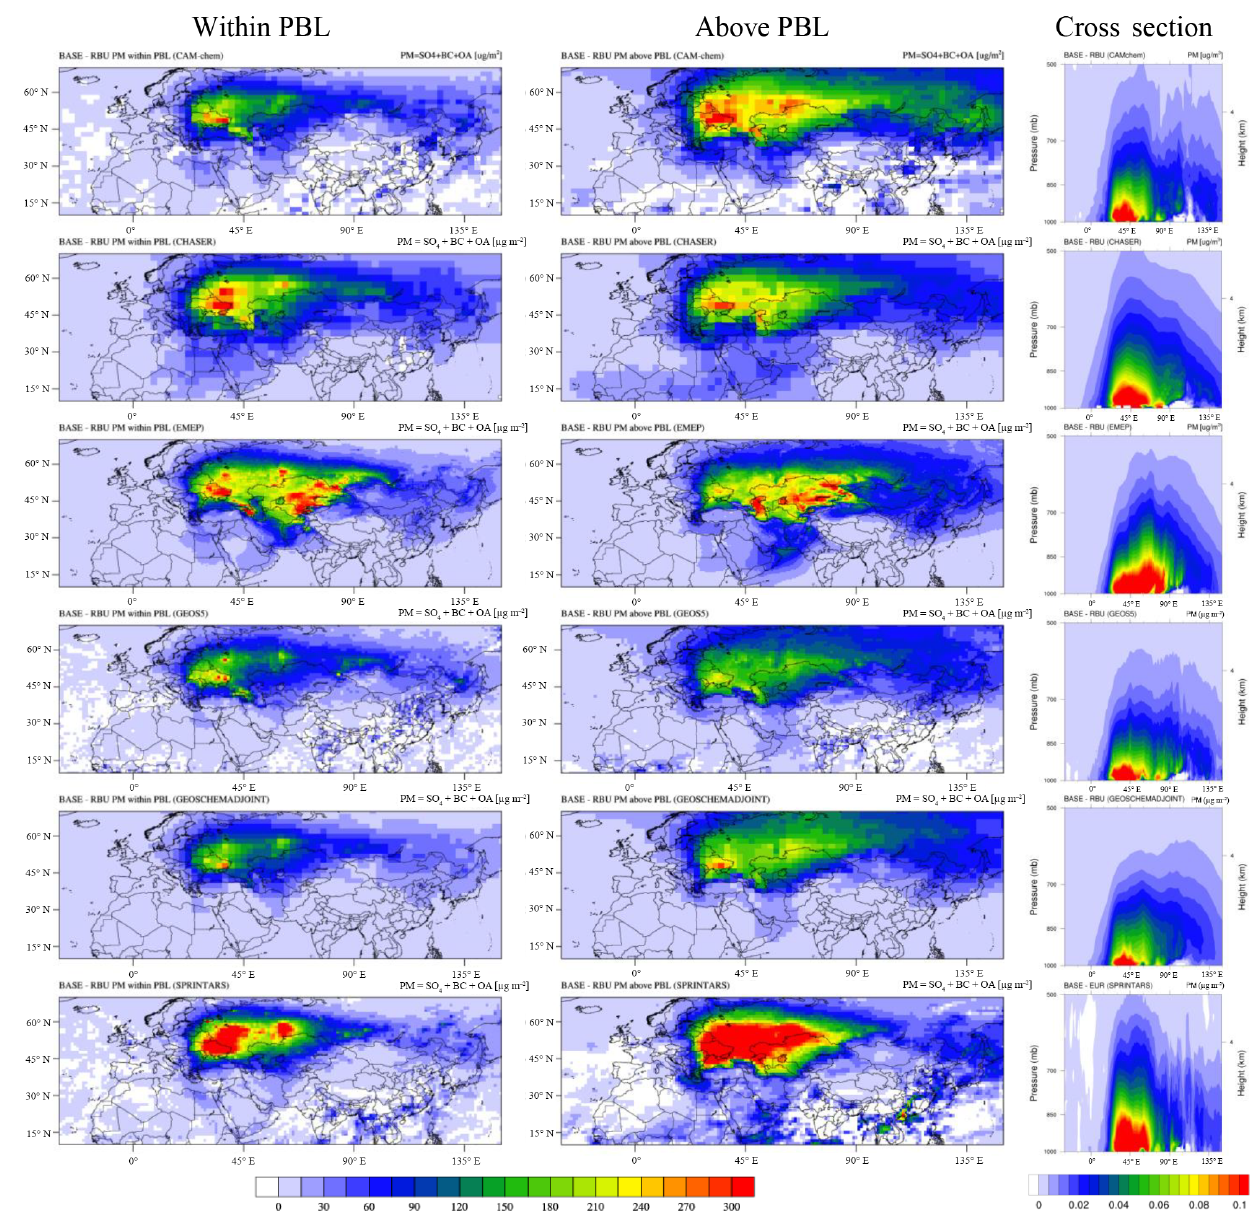
Figure 8. Same as Fig. 7 but under the RUBALL